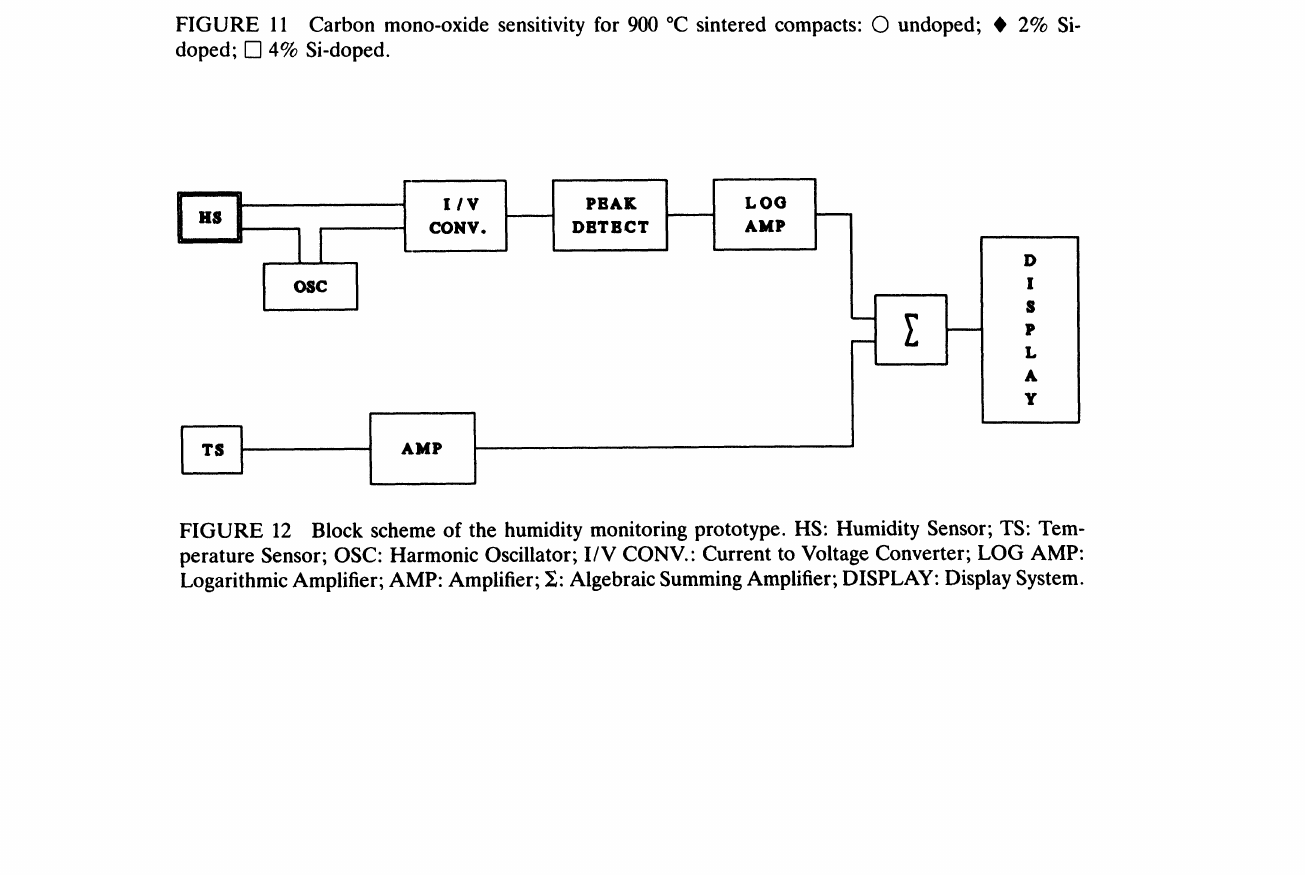
FIGURE 11 Carbon mono-oxide sensitivity for 900 C sintered compacts: C) undoped; 2% Si- doped; !-1 4% Si-doped.